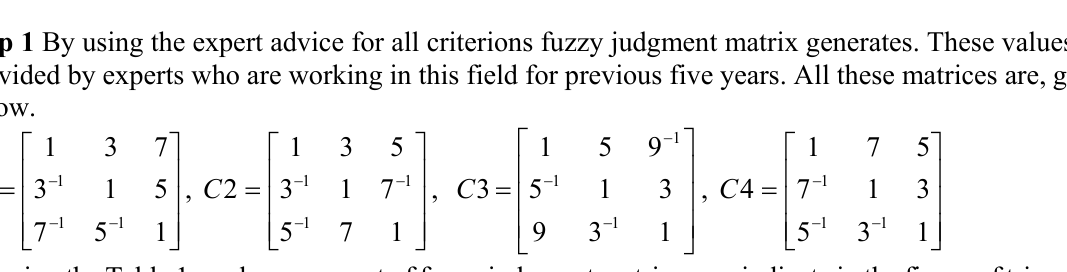
Fig. 4. Hierarchical Structure of analyzability